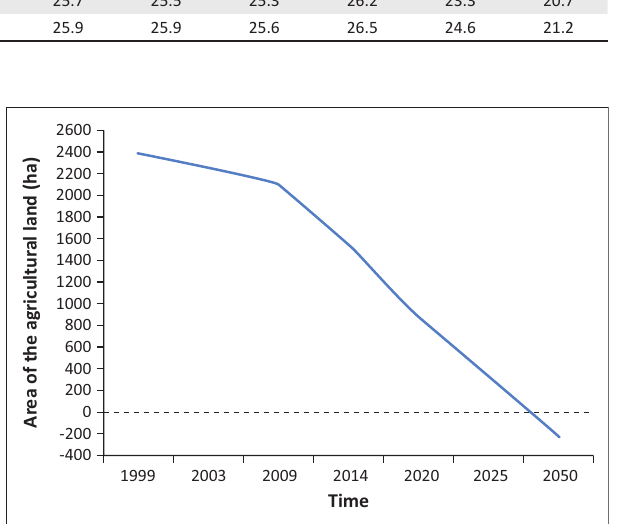
FIGURE 3: Prospective changes in agricultural lands